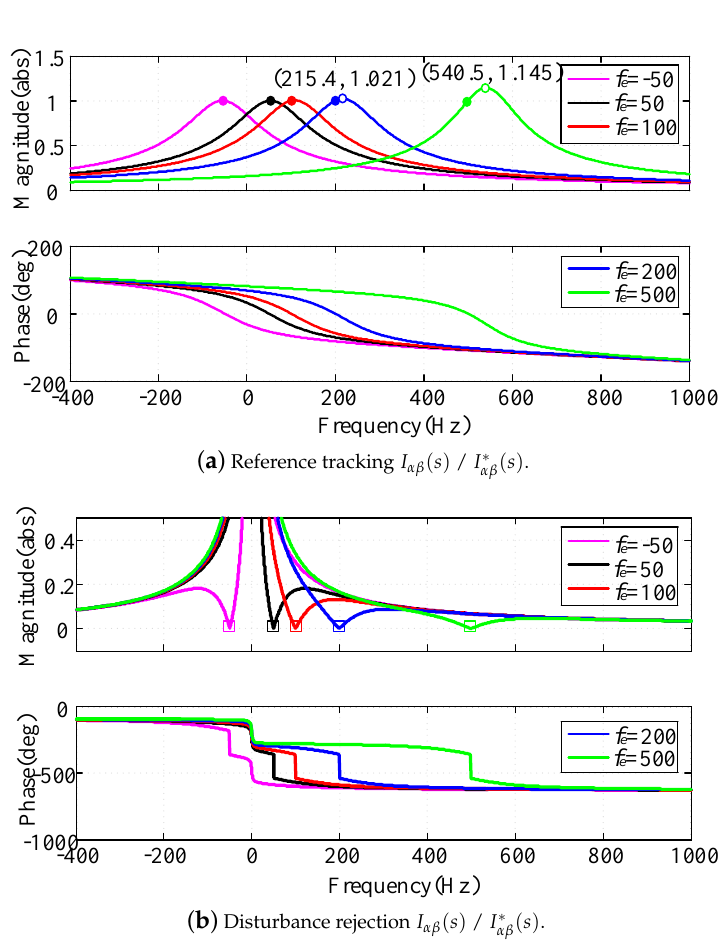
Figure 8. Bode plot of closed-loop current control based on D-PCI